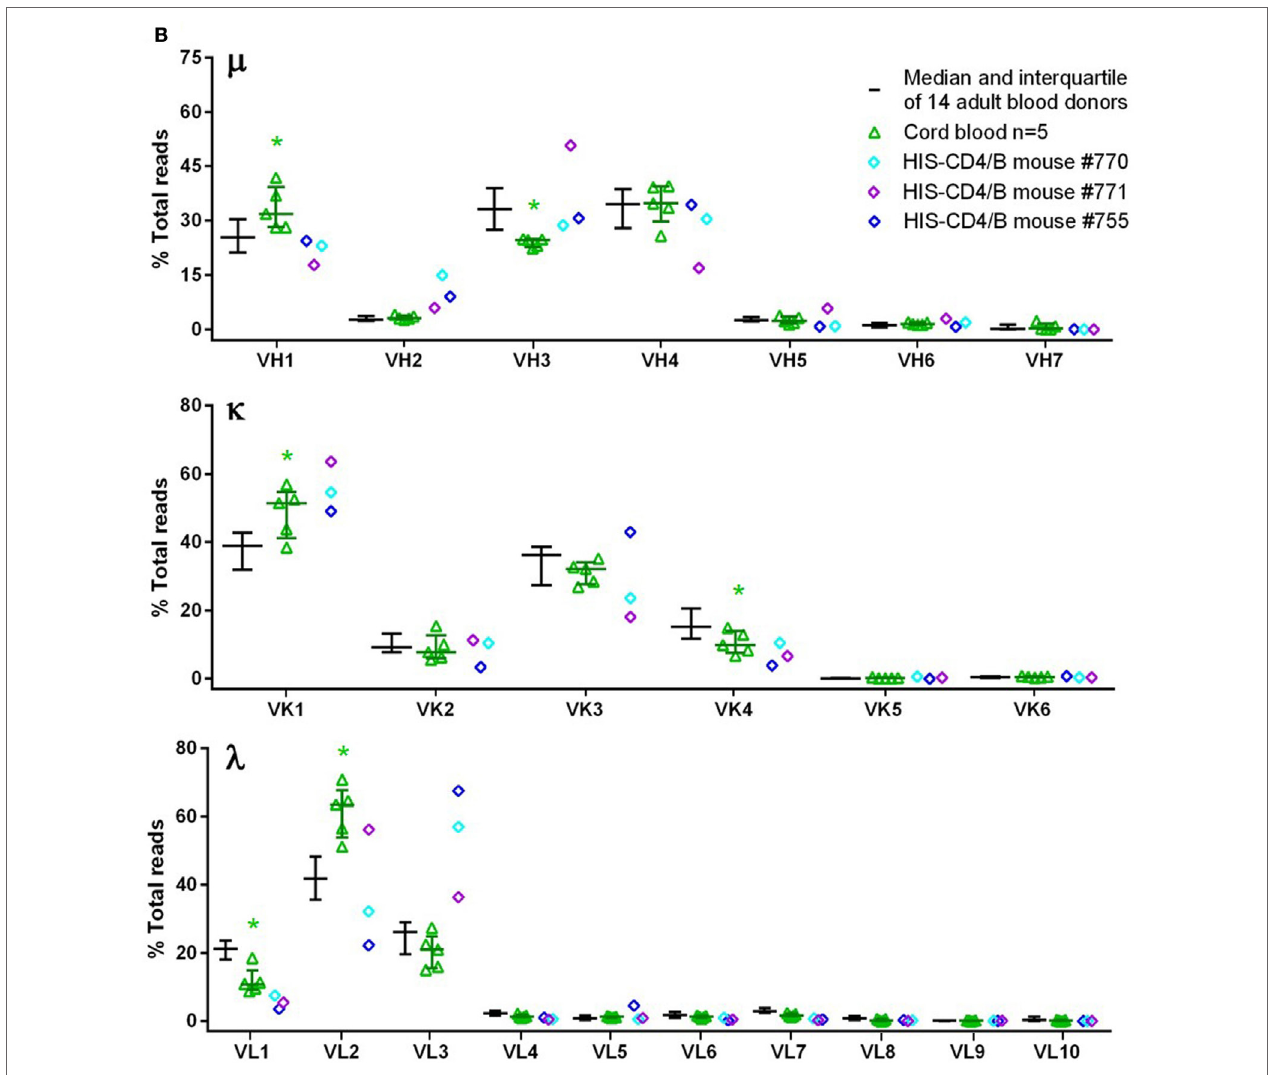
FigUre 1 | V-gene family usage for μ , γ , α , κ , and λ chains in blood donor PBMCs, HIV-1 + PBMCs, cord blood, and HIS-CD4/B mice. Each panel shows a heavy or light chain as indicated. The y -axis shows the frequency of sequence reads assigned to the V-gene families specified on the x -axis. (a) Comparisons between blood donors (gray circles) and HIV-1 + donors (red circles). Note that α data were only available for three HIV-1 + donors. (B) Comparison among adult blood donors (black bars), cord blood (green triangles), and three HIS-CD4/B mice (diamonds). Bars indicate the medians and interquartile ranges. Asterisks depict statistical significance between the indicated groups and the adult blood